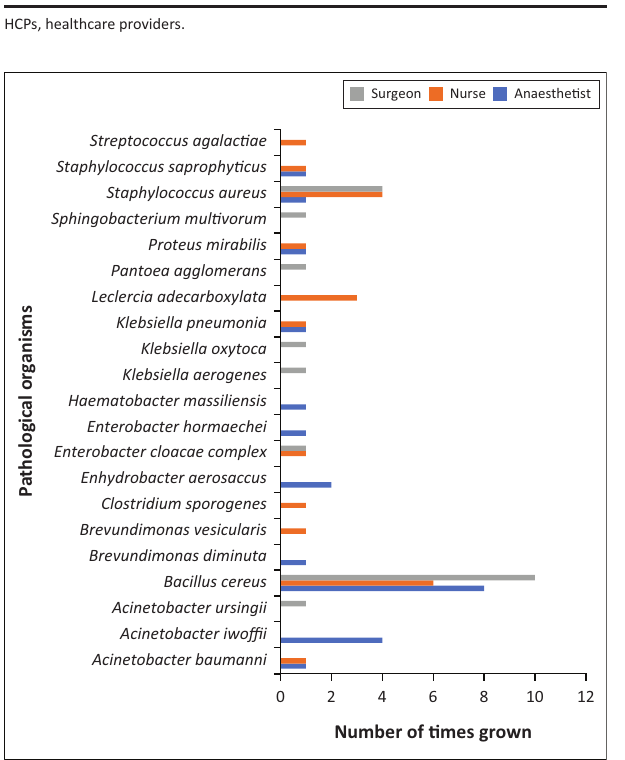
FIGURE 1: Pathological growth amongst each group of healthcare workers.